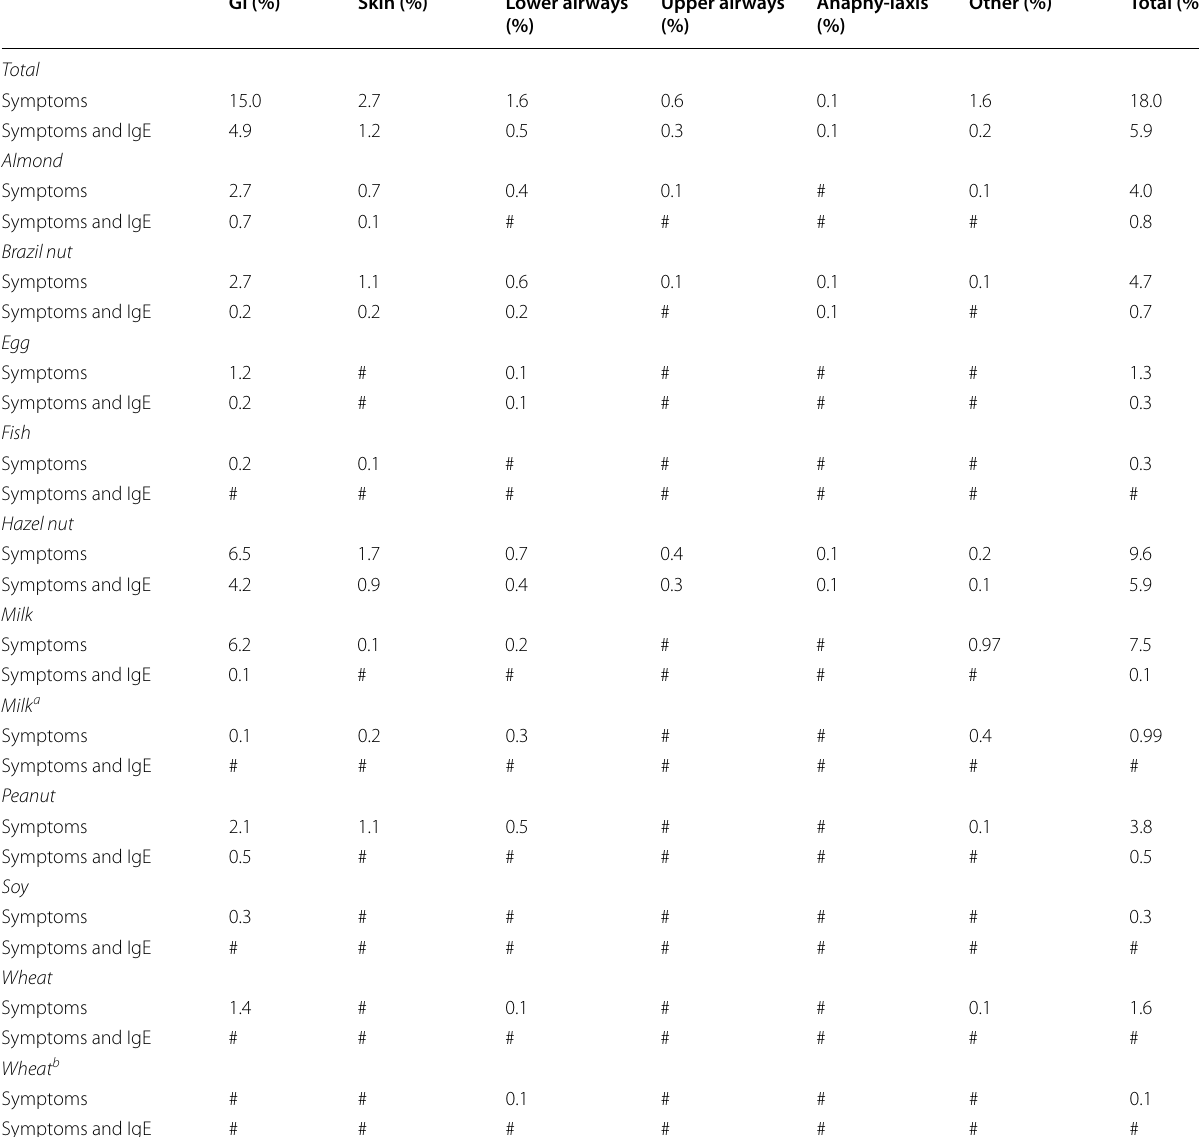
Table 5 The percentage of subjects with self-reported symptoms and IgE-sensitization for common foods, divided into symptoms from the gastrointestinal tract (GI-tract), skin, lower and upper airways, anaphylaxis and other symptoms (as described and encoded in Table